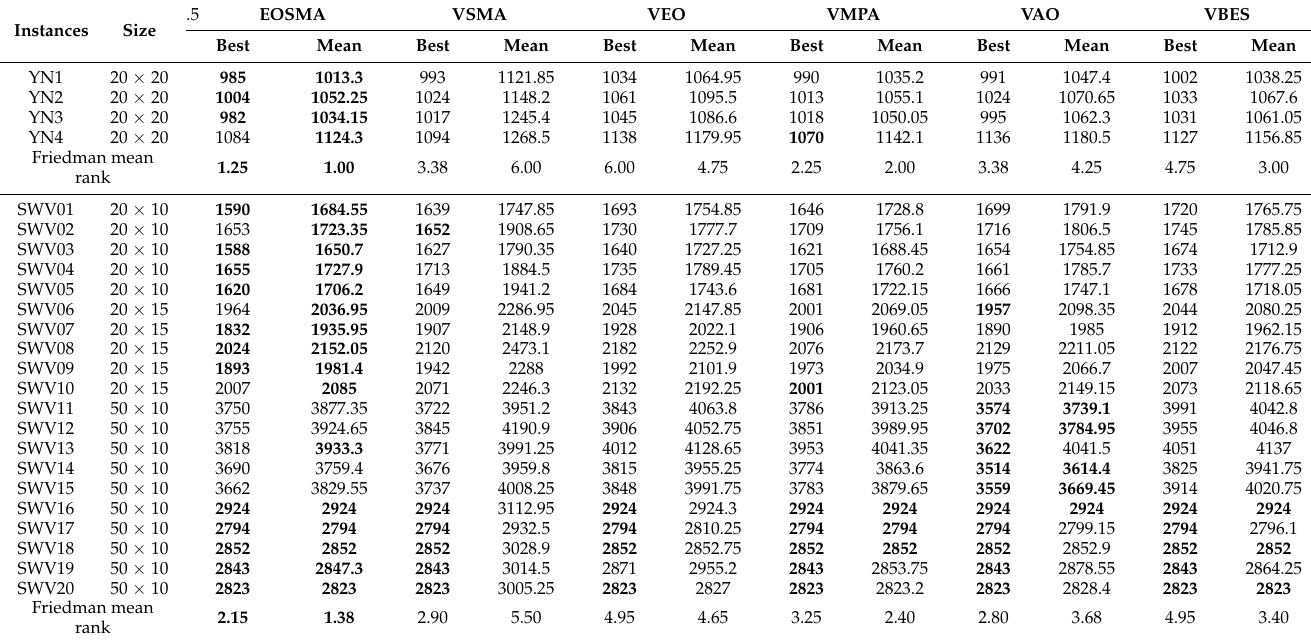
Table 7. Comparison of solution results of algorithms on YN and